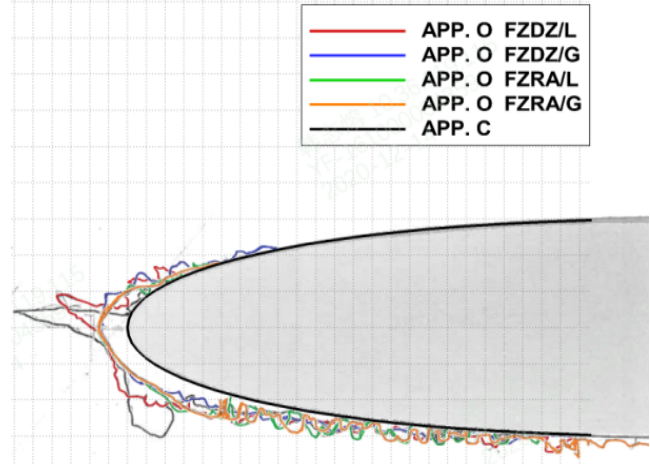
Figure 12. Ice shapes with single horn at AOA = 4.9°.